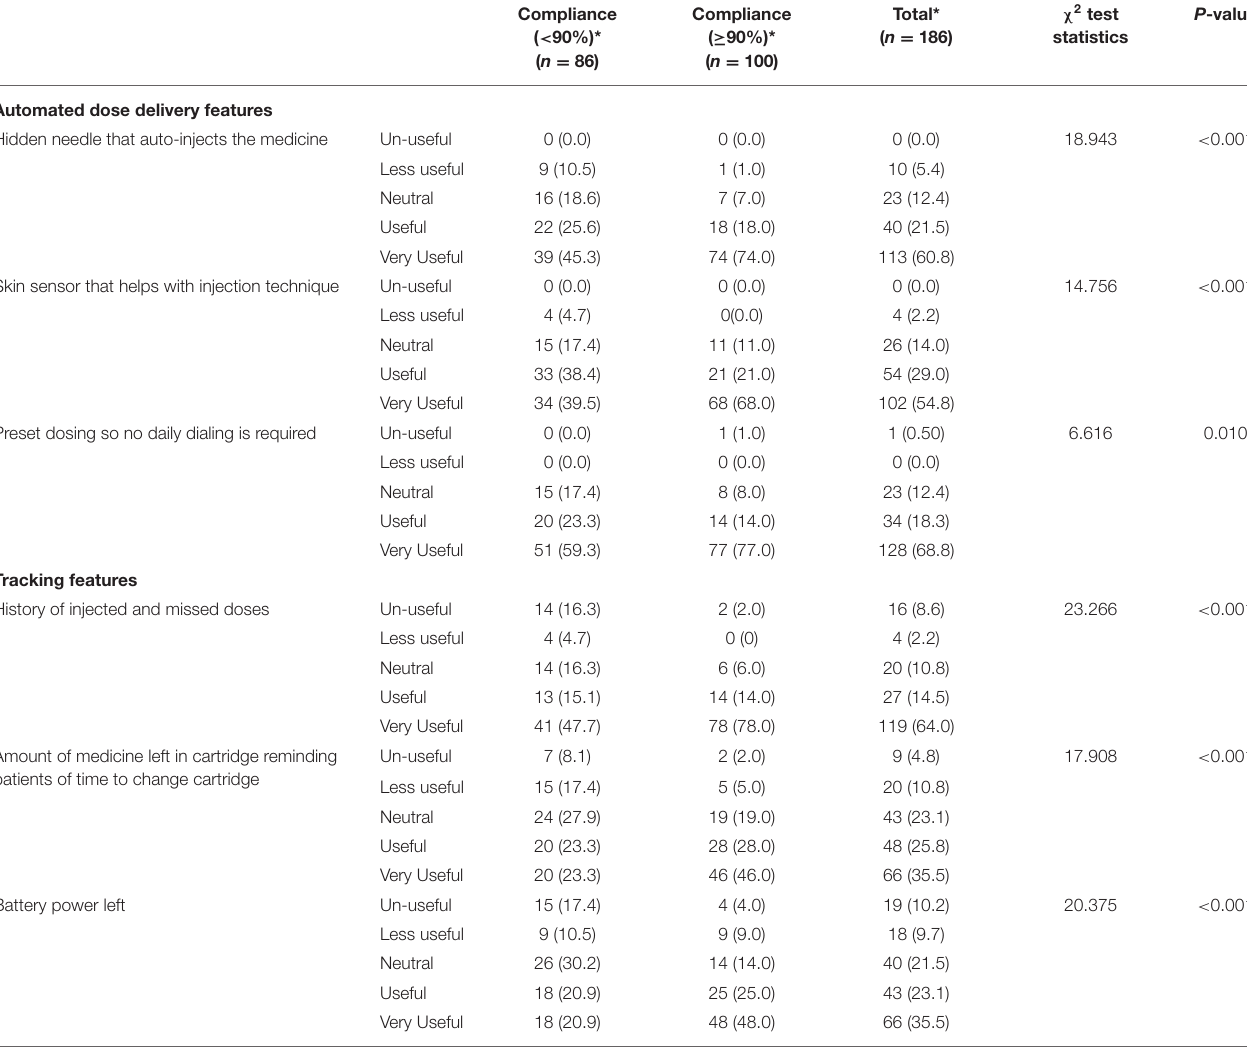
TABLE 2 | Comparison between compliance groups for the usefulness of automated dose delivery and tracking features ( N = 186).